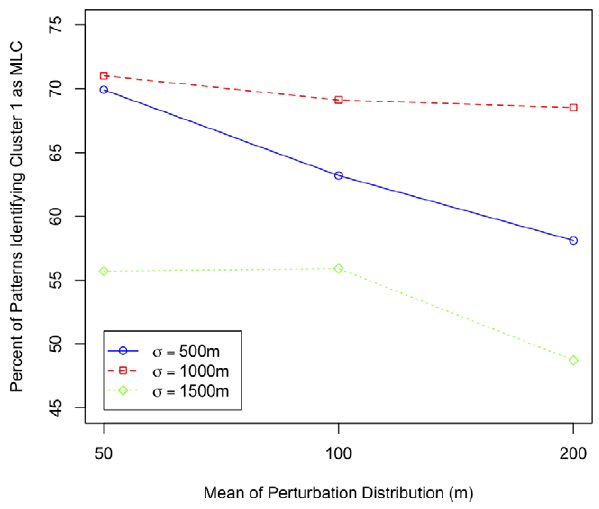
Figure 7. Percentage of patterns where Cluster 1 was reported as the MLC across the different intensity/perturbation combi- nations.